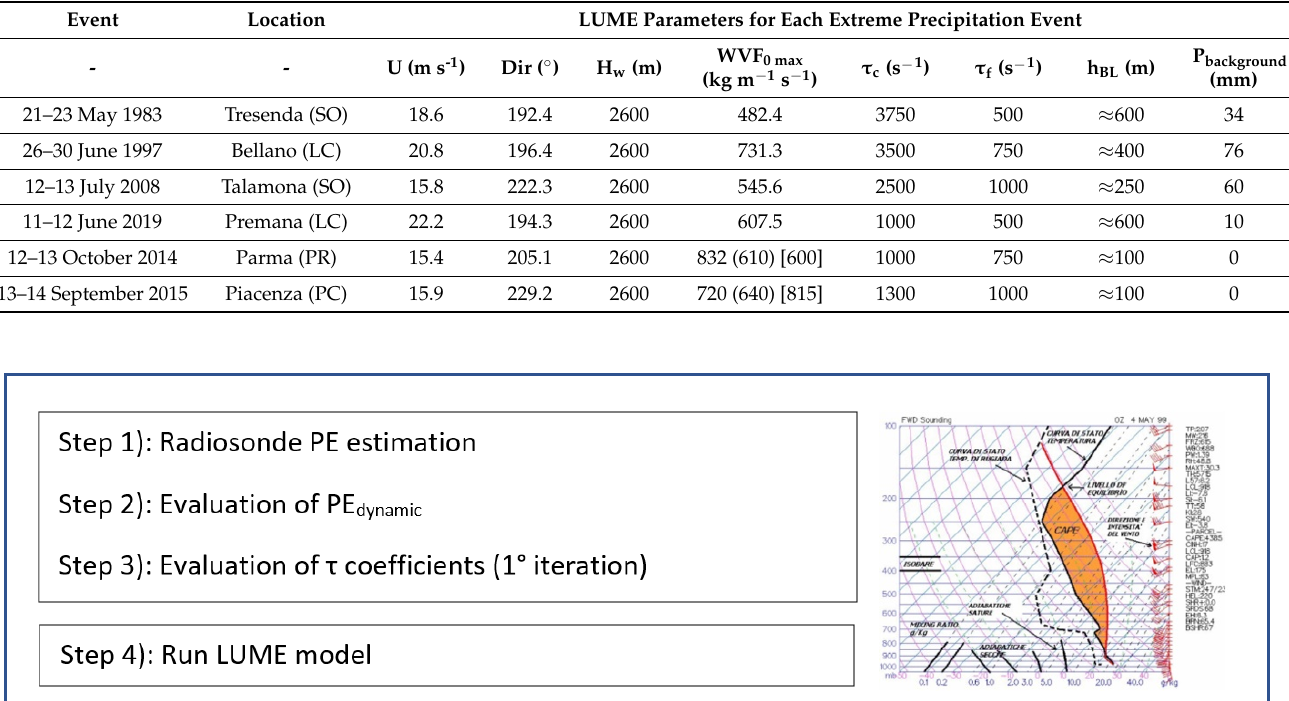
Table 3. LUME parameters for extreme precipitation modelling. For 2014 and 2015, due to the greater distance of the Ajaccio radiosonde station from the location of events (300 km), we also considered the Cuneo () and Linate [] radiosonde stations (150 km and 100 km) located downstream.